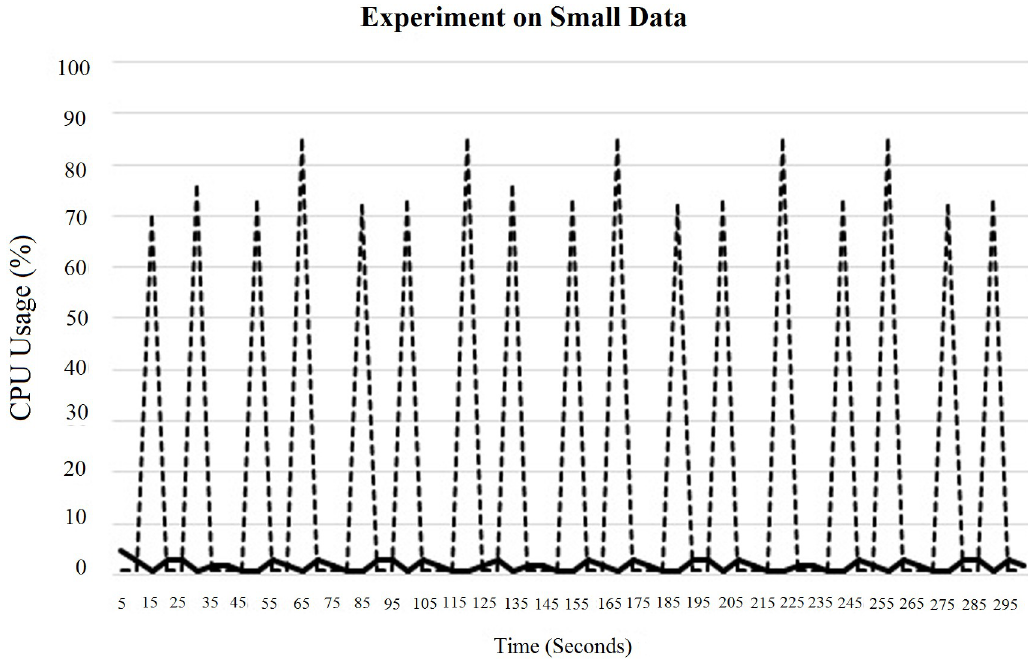
Fig 20. CPU usage with tuned map tasks for a single DataNode using small data.